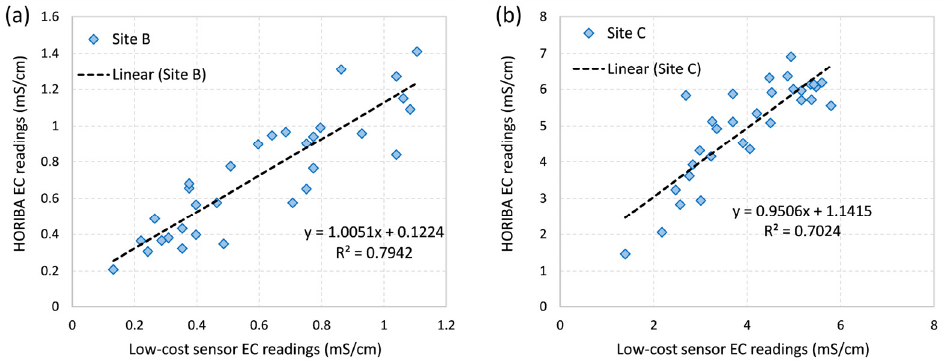
Figure A3 . ( a ) The correlation between low-cost EC sensor readings and HORIBA measurement at Site B; ( b ) the correlation comparison at Site C.